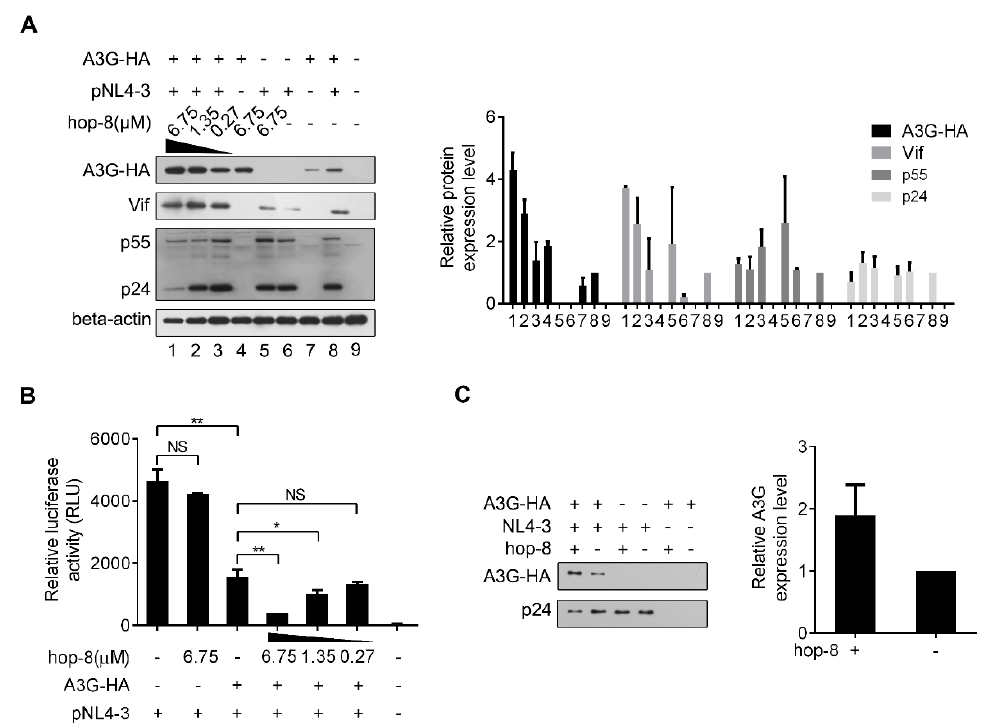
Figure 4. Hop-8 enhanced the expression of A3G and reduced p24 expression in HIV-1 producing cells and reduced the infectivity of the produced virus. ( A ) Hop-8 increased the expression of A3G and Vif while reduced the p24 expression in HIV-1 producing cells. The plasmids pcDNA3.1-APOBEC3G-HA (0.125 μ g) and pNL4-3 (0.375 μ g) were transfected into 2 × 10 5 293T cells. The compound was diluted to 6.75, 1.35, and 0.27 μ M with DMEM and added to the wells 6 h post-transfection. The relative expression levels of A3G-HA, Vif, p55, and p24 were normalized by the levels of beta-actin. Values are presented as normalized intensities relative to the values of the pNL4-3 and A3G-HA positive groups (lane 8). Each data point represents the mean relative quantity ± standard deviation (bars), n ≥ 3. ( B ) Hop-8 reduced the infectivity of the progeny virus. The supernatant of NL4-3 was collected and 4 × 10 4 TZM-bl cells were infected with NL4-3 that contained 20 ng p24. The residual infection was determined using relative luciferase activity. All data represent the means ± standard deviation (bars), n ≥ 3. Data were analyzed by the unpair-sample t -test with Origin 8.5. ( p < 0.05, significant difference; *: p < 0.05; **: p < 0.01; NS: not significant). ( C ) Hop-8 increased the incorporation of A3G in progeny virions. pcDNA-APOBEC3G-HA (1 μ g) and pNL4-3 (1 μ g) were transfected consecutively or co-transfected into 293T cells in 6-well cell culture plates. Cells were cultured with or without hop-8 (2.7 μ M) for 48 h. The supernatant was collected and centrifuged at 2000× g and the cell debris was discarded. The viral particles were lysed with 0.5% Triton-X100. A3G and p24 levels in the supernatant were determined by western blot. The relative expression levels of A3G-HA were normalized by the levels of p24. Each data point represents the mean relative quantity ± standard deviation (bars), n ≥ 3.